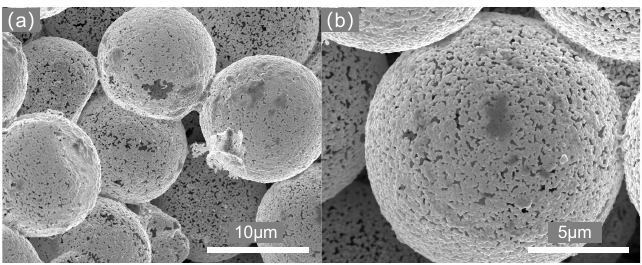
Figure 2. Structural characterization of hollow Au foam: main backbone consisted of hollow sphere-packing model ( a ) and bicontinuous network in the shell ( b